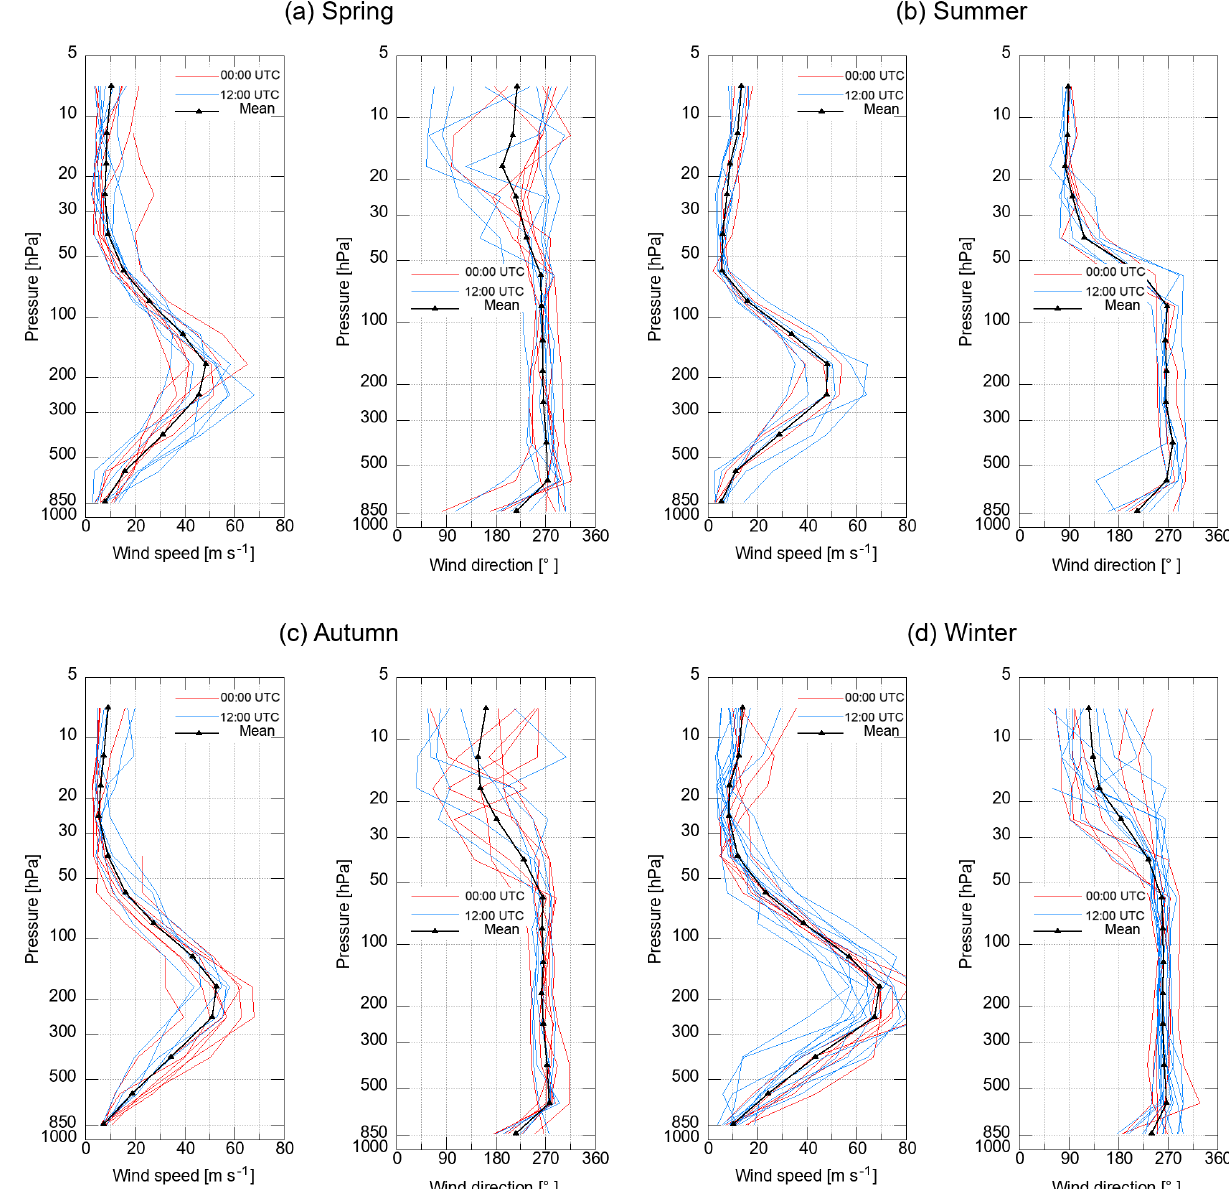
Figure 16. Seasonal profiles for wind speed and direction (as for Fig.